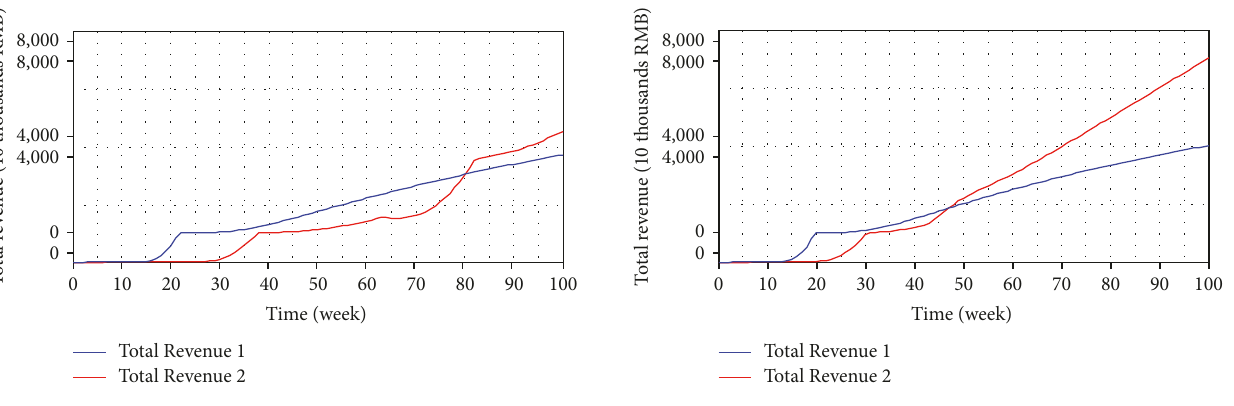
Figure 6: Total Revenue contrast 1.